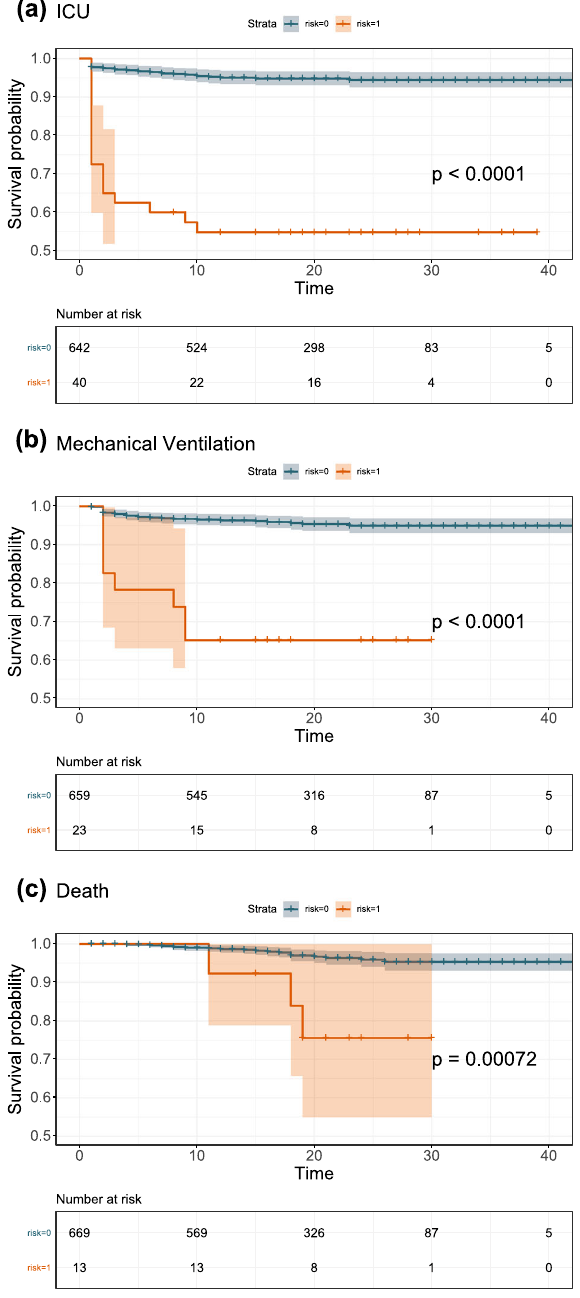
Fig. 4 Kaplan – Meier curves for 3 tasks in Cohort 2. Risk groups were divided according to model predicted scores. a ICU admission, b mechanical ventilation, and c death (high-risk: risk = 1, low-risk: risk =